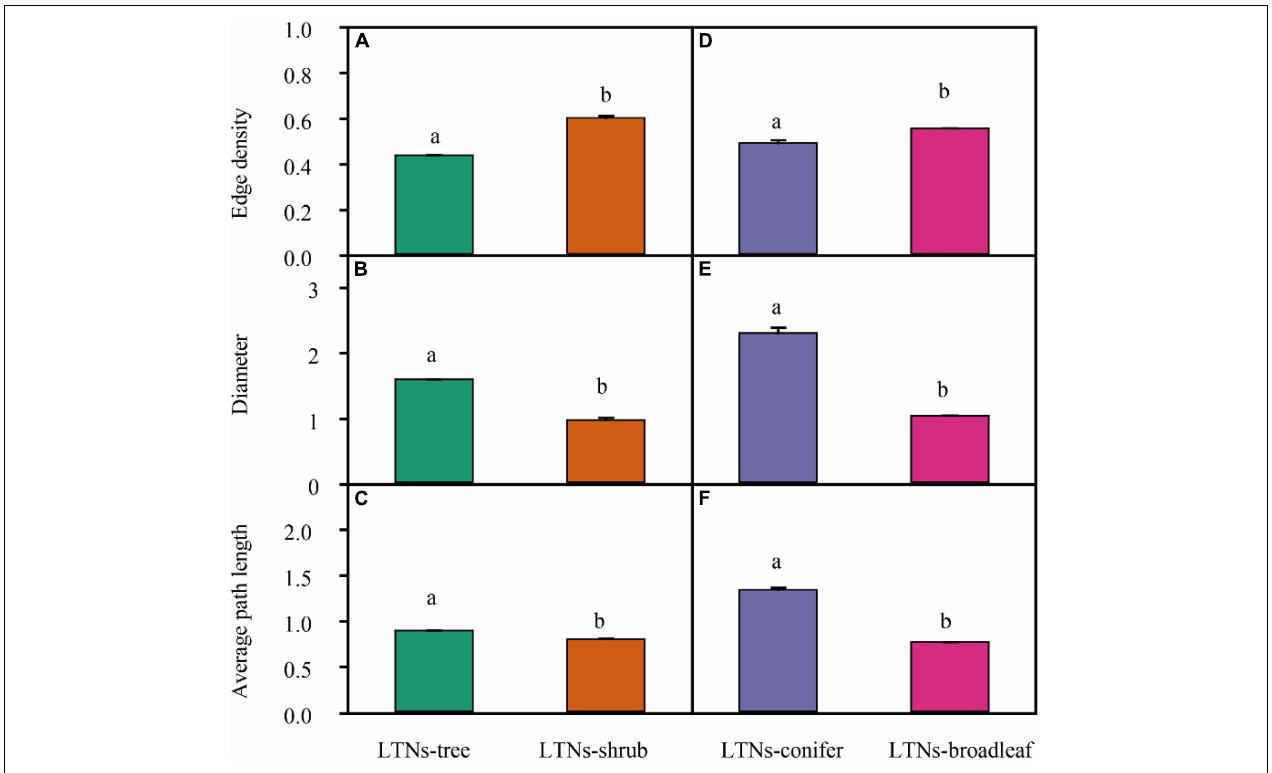
FIGURE 5 | Variation in the overall parameters of leaf trait networks (LTNs) among different plant growth forms (A–C) and plant life forms ( D–F ). Different letters show a significant difference between two networks ( P < 0.05). Error bars represent standard error